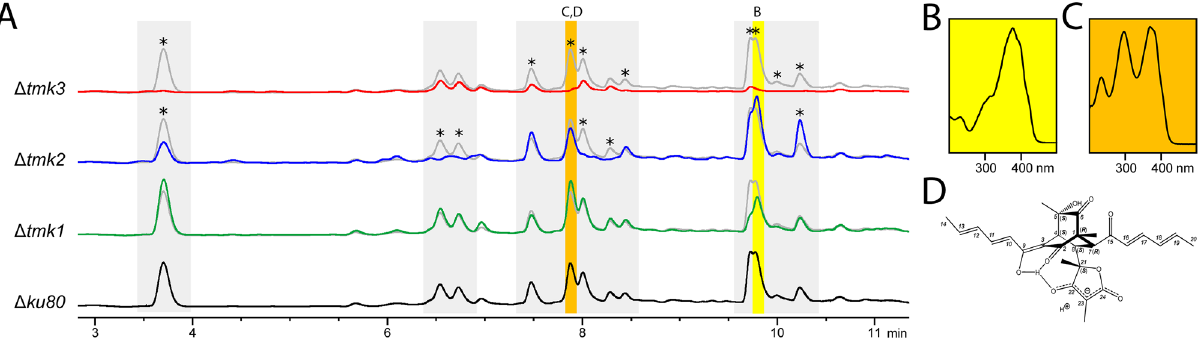
Figure 5. HPLC analysis of MAPK deletion mutants and identification of sorbicillin derivatives. ( A ) Chromatograms of wild-type ( Δku80 ) and MAPkinase deletion mutants (Δ tmk1-3 ) at 230 nm. Wild type profile is shown in grey for better comparission. Asterisks indicate strongly regulated peaks. Trichodimerol is highlighted in yellow and (21 S )-bisorbibutenolide in orange. ( B ) UV-spectrum of trichodimerol. ( C ) UV-spectrum of (21 S )-bisorbibutenolide. ( D ) (21S)-bisorbibutenolide 98 . Numbering of protons and carbons is shown in Fig. 5D and in agreement with those used previously 98